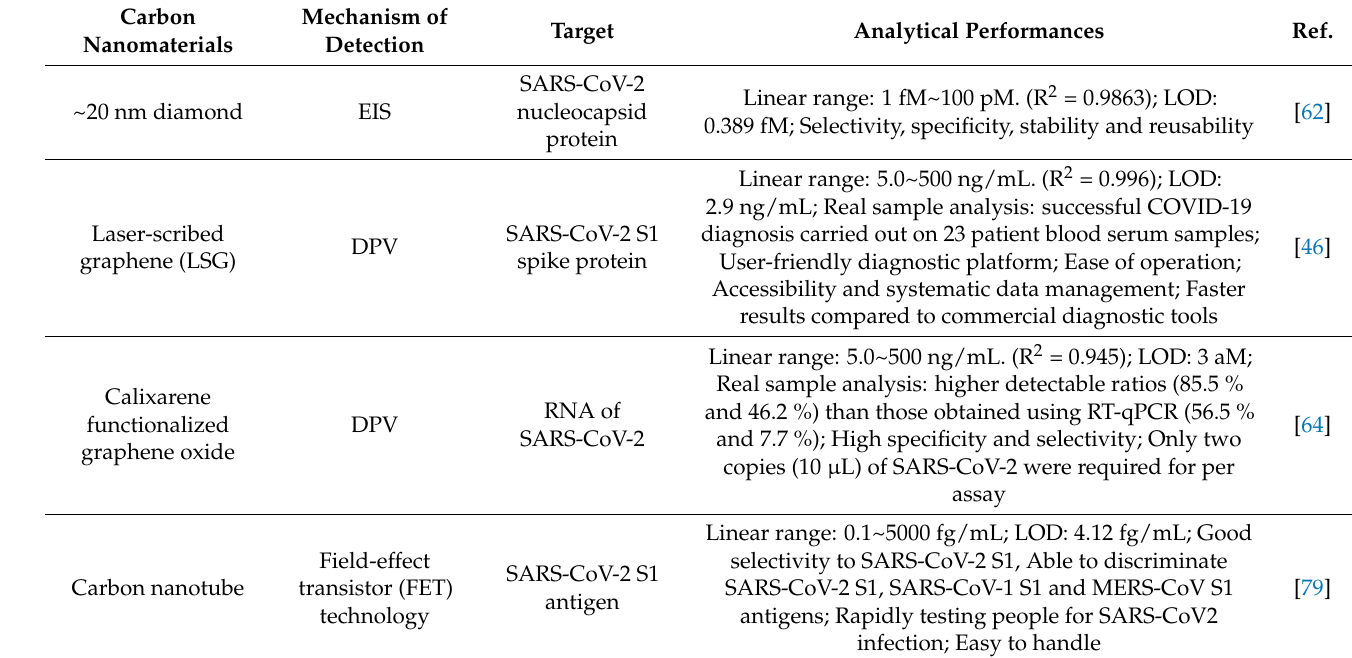
Table 2. Performances of electrochemical biosensors for COVID-19